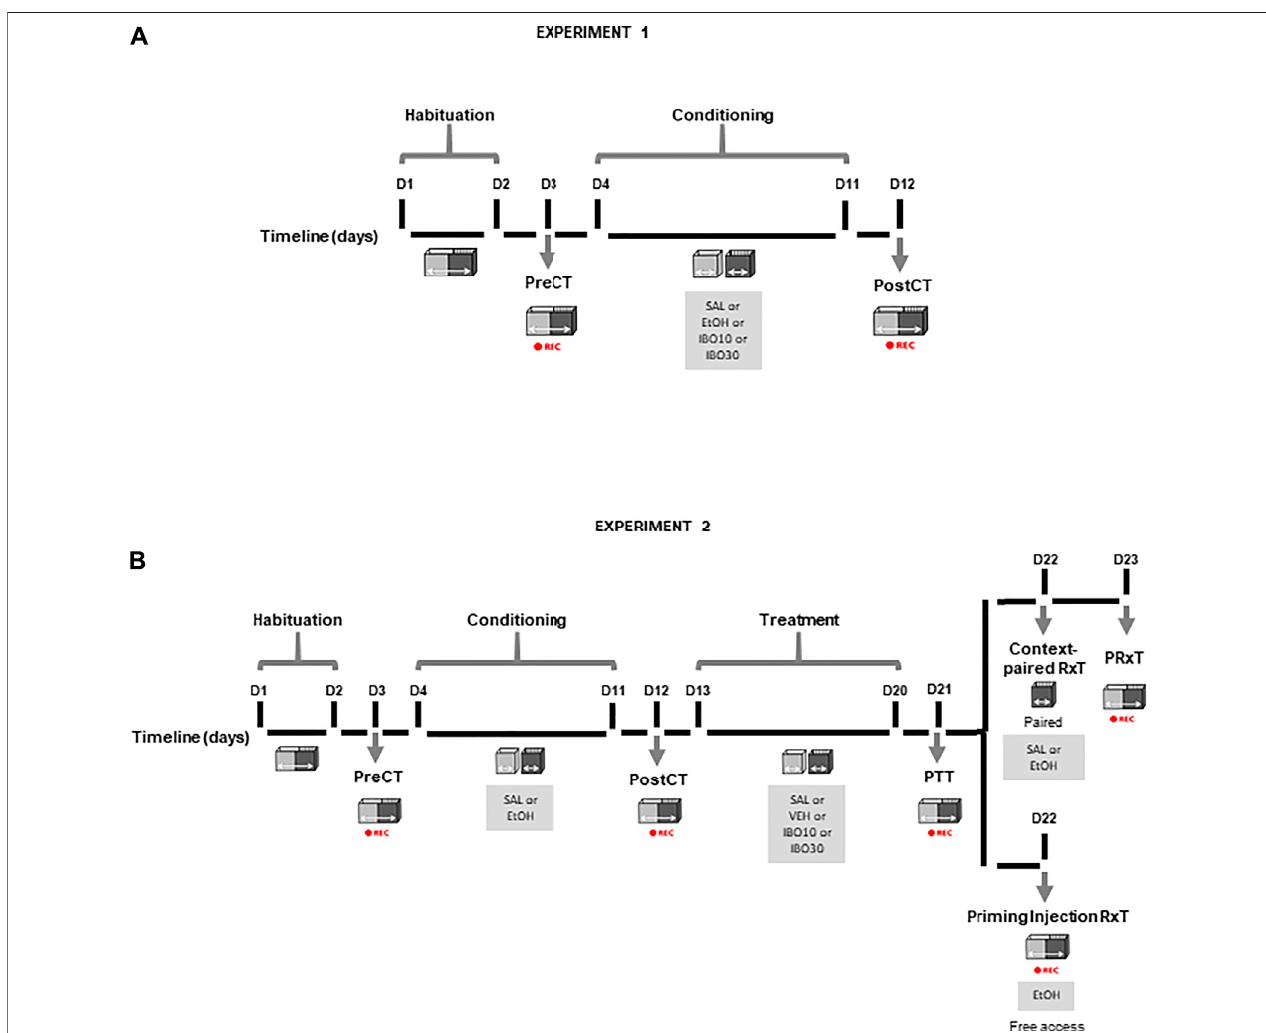
FIGURE 1 | Conditioned place preference (CPP) protocol design across experimental days (D). (A) Experiment 1 (B) Experiment 2. PreCT: drug-free pre- conditioning test. Conditioning: saline (SAL), ethanol (EtOH, 1.8 g/kg) or ibogaine (IBO, 10 or 30 mg/kg) conditioning alternated with saline conditioning. PostCT: drug- free post-conditioning test. Treatment: saline (SAL), vehicle (VEH) or ibogaine (IBO, 10 or 30 mg/kg) treatment in the compartment previously paired with ethanol; PTT: drug-free post-treatment test. Context-paired RxT: context-paired re-exposure, in which animals received an injection of saline (SAL) or ethanol (EtOH, 1.8 g/kg) andwerecon fi nedtothecompartmentpreviouslypairedwithethanol.PRxT:drug-freepost-context-pairedre-exposuretest.PrimingInjectionRxT:priminginjectionre- exposure test, in which animals received an injection of ethanol (EtOH, 1.8 g/kg) and had free access to both compartments of the CPP apparatus. REC: